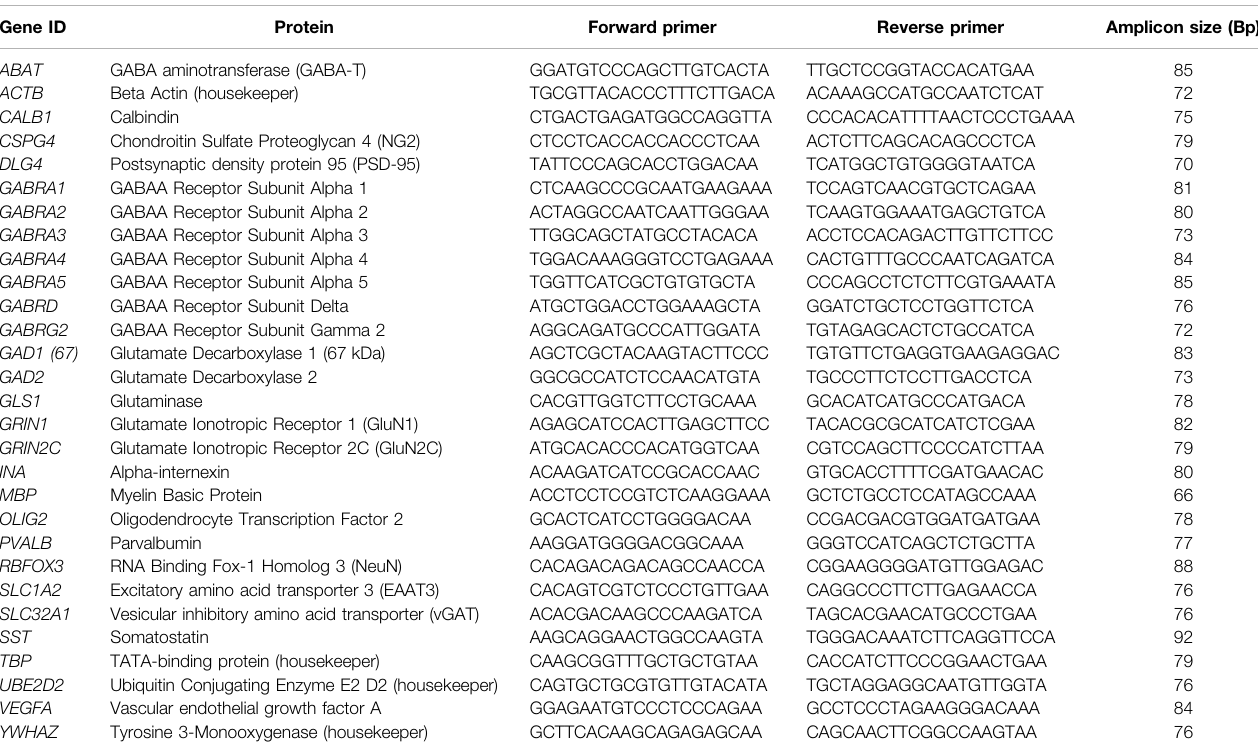
TABLE 2 | Guinea pig speci fi c primers for real time